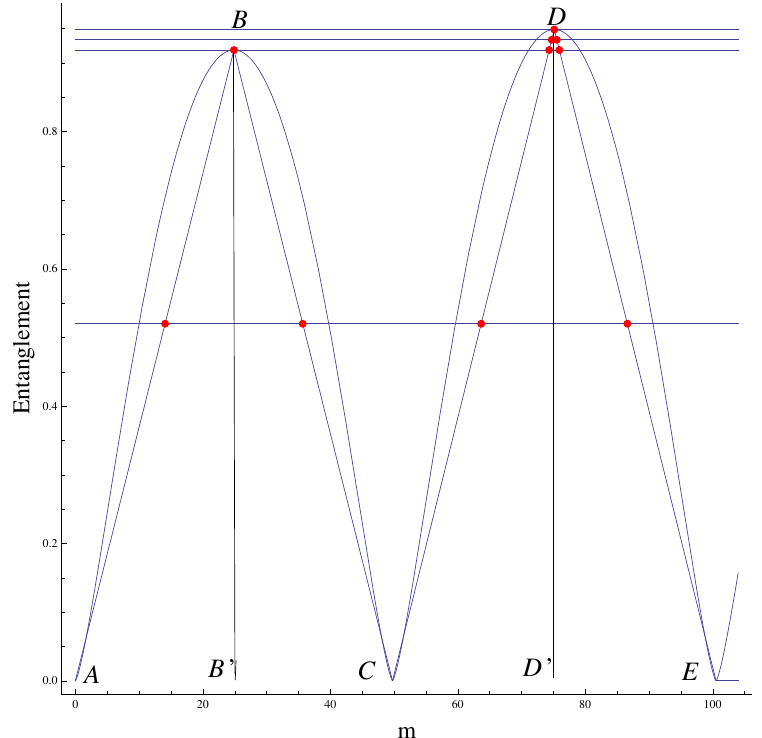
Figure 4. Plots of E Ren ( m ) and tent map f ( m ) for a = 0.7, n = 12, r = 3, p = 1/ N . Red dots stand for the approximate points of equal